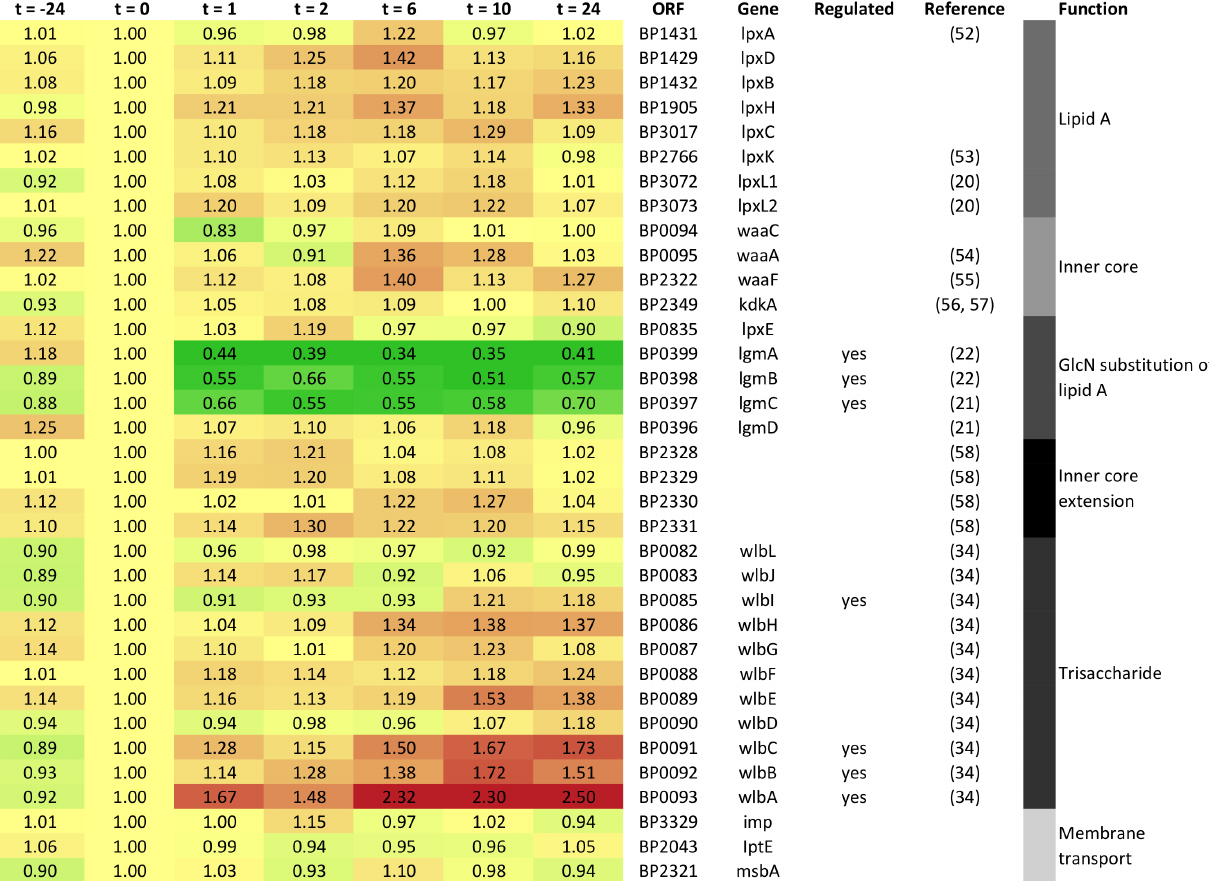
Fig 6. Expression of genes associated with LPS synthesis and modification in B . pertussis in response to sulfate exposure. Relative gene expression of a panel of 35 genes associated with LPS synthesis or modification in B . pertussis [25 – 27, 41, 44 – 50]. Each row represents the relative transcript abundance of a single gene in B . pertussis bacteria harvested before and at different time points after sulfate addition to the growth medium. Column names (t = -24 – t = 24) correspond to the time points after the addition of sulfate at which bacteria were harvested (0 = vaccine A ref , 2h = vaccine B, 6h = vaccine C, 12h = vaccine D, 24h = E). The colour scale indicates gene regulation ranging from strong downregulation (dark green), to no regulation (yellow), and strong upregulation (dark red). Genes for which the expression changed significantly throughout the production process are marked with an asterisk (p <